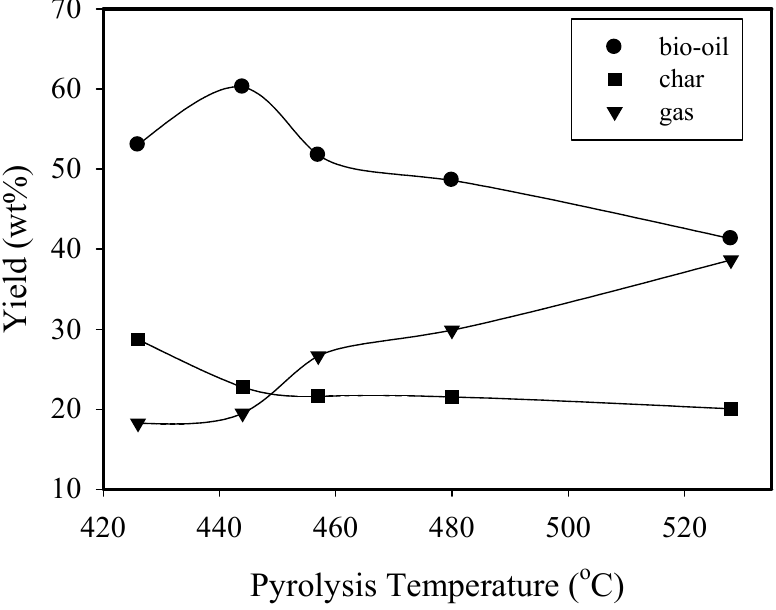
Figure 2. Effect of pyrolysis temperature on the product distribution for fast pyrolysis of wood sawdust (0.8 kg/h feeding rate, 15 L/min N 2 carrier gas flow rate).